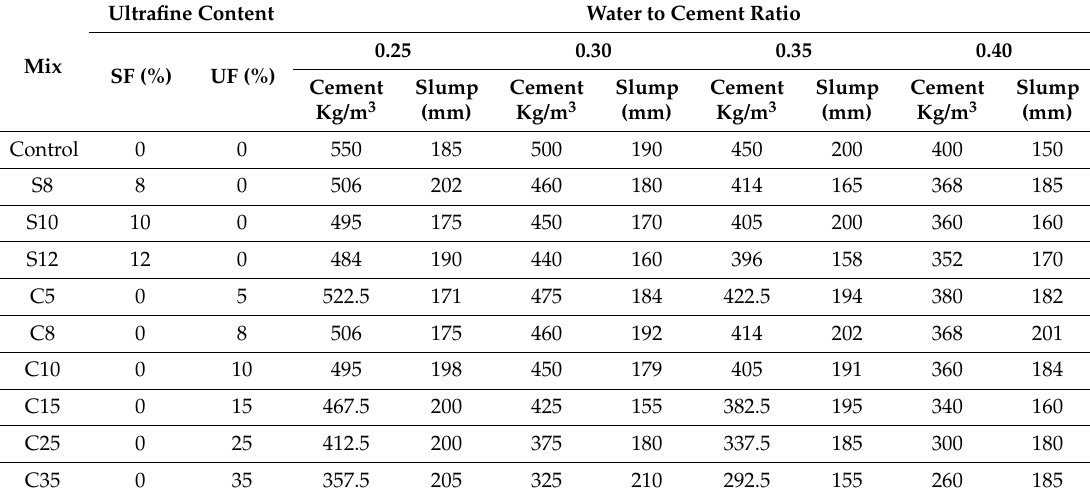
Table 3. Mix proportions of silica fume (SF) and ultrafine (UF) for all